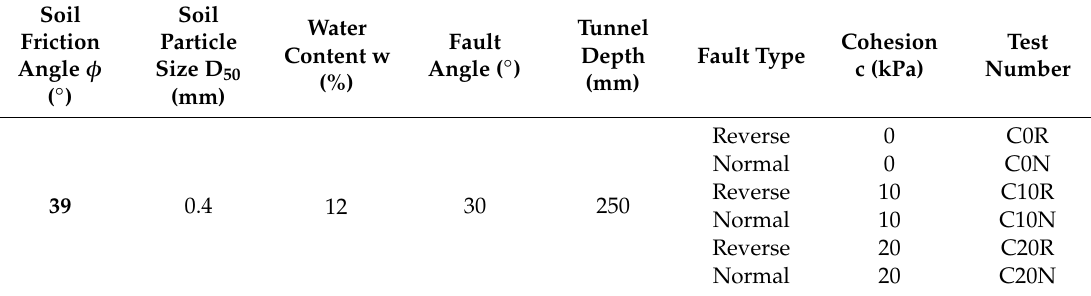
Table 3. Soil properties used for various soil cohesion.